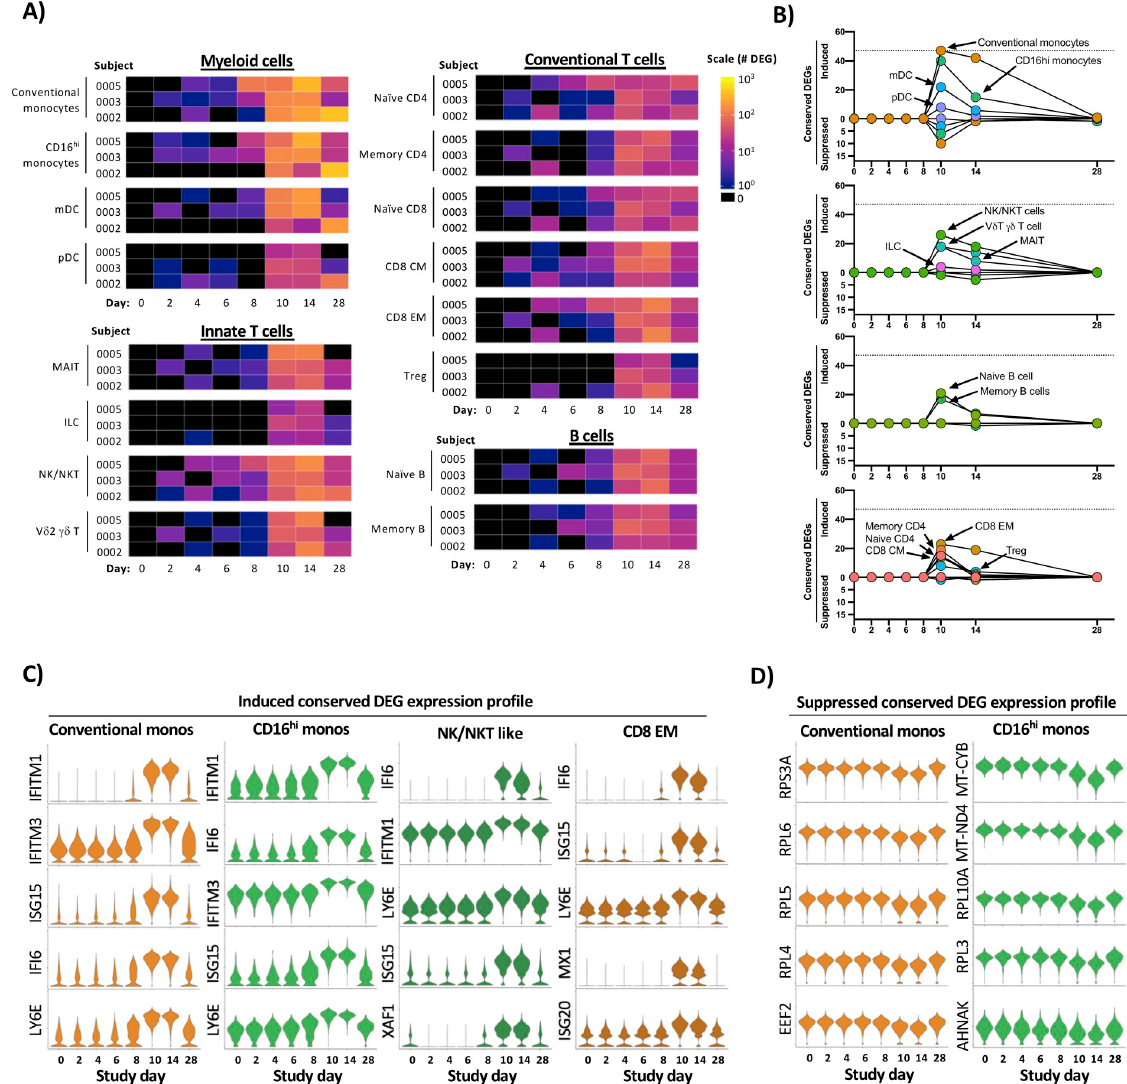
Fig 3. Temporal and transcriptional characterization of experimental primary DENV-1 infection and identification of conserved gene signatures. A) Quantification of differential gene expression across all major leukocyte populations following experimental primary DENV-1 infection. Subject- and population-specific differentially expressed genes (DEGs) were defined by a Wilcoxon rank-sum test with a Bonferroni correction relative to study day 0 for each subject. B) Population-restricted frequency and temporal dynamics of cDEGs across all experimental primary DENV-1 infection subjects. Conserved DEGs defined as DEGs observed in all three subjects at the same time point relative to baseline. C) Expression of select upregulated cDEGs from study day 10 within the indicated cell populations across all study time points. D) Expression of select suppressed cDEGs from study day 10 within the indicated cell populations across all study time points.